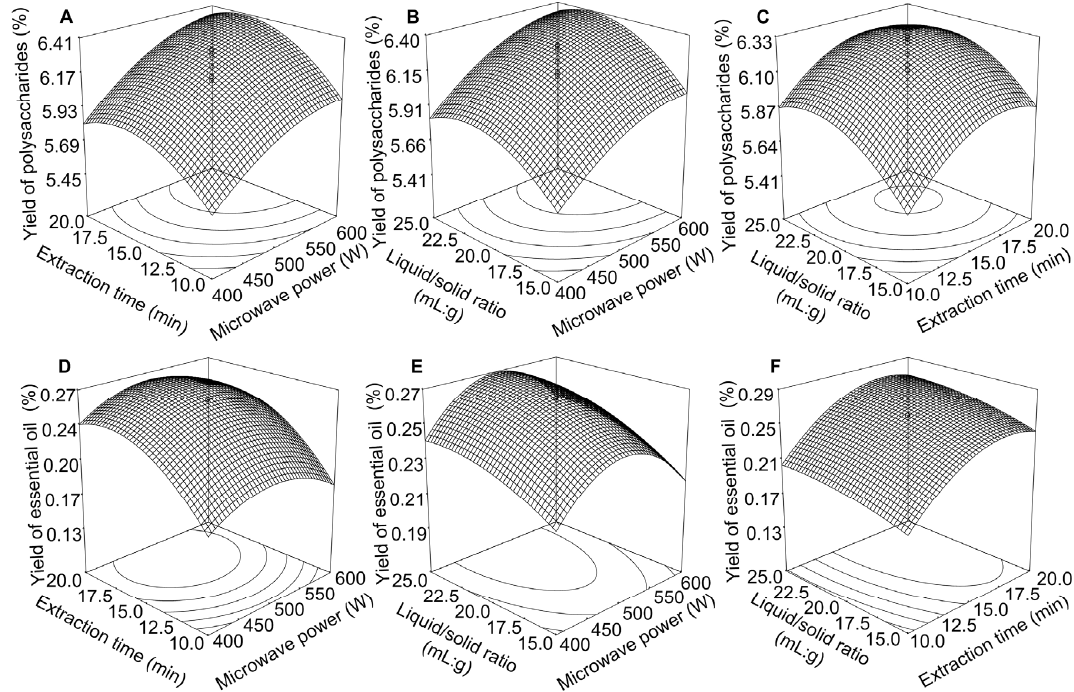
Figure 4. Response surface plots for the extraction of the polysaccharides and essential oil using the MA-SDE method: impact of the extraction time and microwave power on the yields of the polysaccharide ( A ) and essential oil ( D ); impact of the liquid/solid ratio and microwave power on the yields of the polysaccharides ( B ) and essential oil ( E ); and the effects of the liquid/solid ratio and extraction time on the yields of the polysaccharides ( C ); and essential oil ( F ).